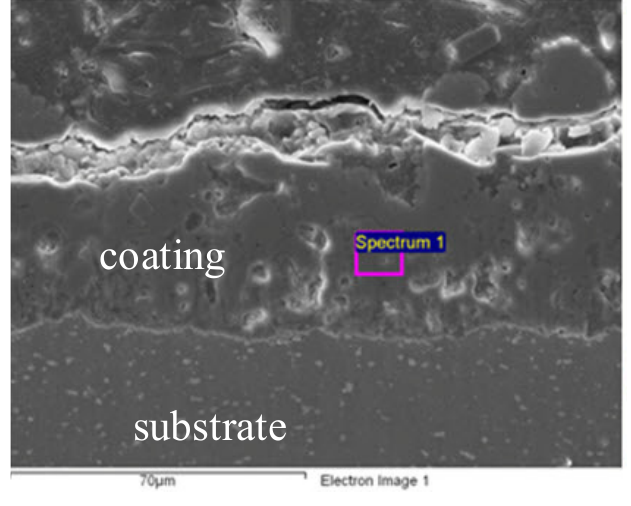
Figure 2. Spectrum process. ( a ) Cross-section of PEO coating; ( b ) spectrum